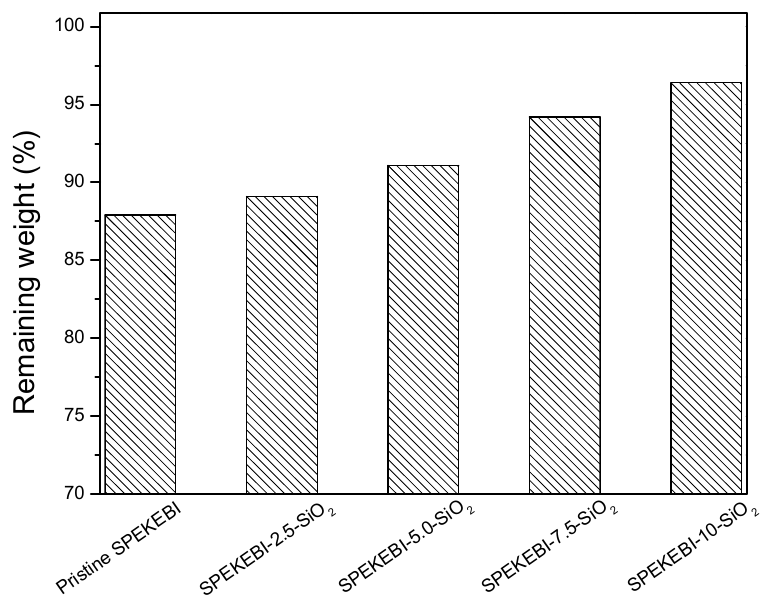
Figure 8. Weight residue of SPEKEBI andSPEKEBI-x-SiO 2 membranes.